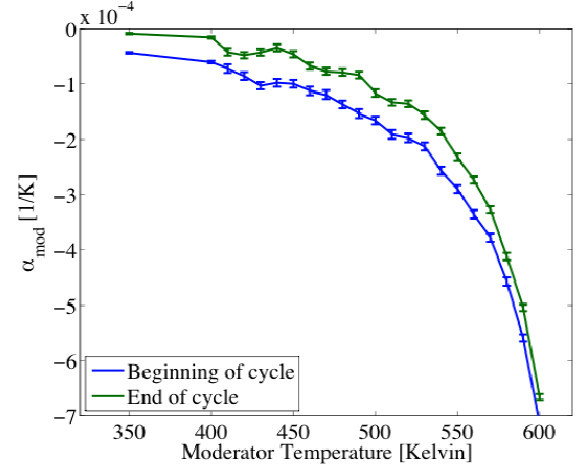
Figure 5. Moderator Thermal Reactivity Coefficients. The reactivity coefficients of the moderator are shown for a range of temperatures at the beginning and end of campaign. The reactor coefficients at the beginning and end of campaign are